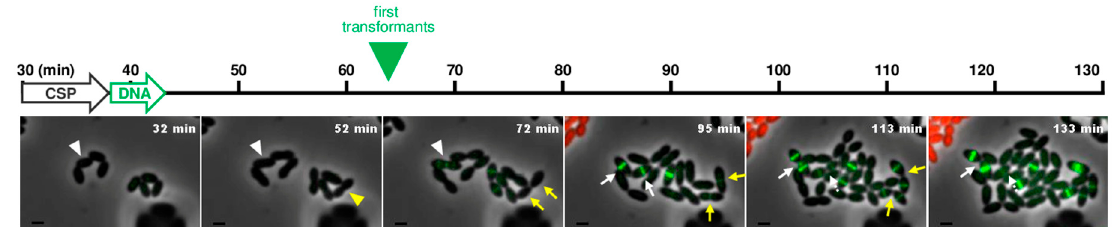
Figure 5. Near real-time visualization of transformation. Time-lapse microscopy of a mixed culture containing strain R3708 R3708 ( ftsZ -stop- gfp ) and strain R4256 (P E - mCherry ). A time scale in minutes is shown. Images were captured at 4min intervals during 2.5 h. White arrow indicates the perfusion period of CSP (starting at 30 min after the beginning of the time-lapse), Green arrow indicates the perfusion period of donor DNA (PCR fragment encoding functional ftsZ-gfp fusion) and green triangle indicates the initial time at which the green FtsZ-GFP fluorescence signal (i.e., transformed cells) is visually detected. Overlays between phase contrast (grey), GFP (green) and mCherry (red) are shown. White arrowheads and arrow indicate transformed cells expressing FtsZ-GFP before the first cell division event, yellow arrowheads and arrows point at transformed cells expressing FtsZ-GFP after division. The data are representative of three biological replicates. Scale bar, 1 µ